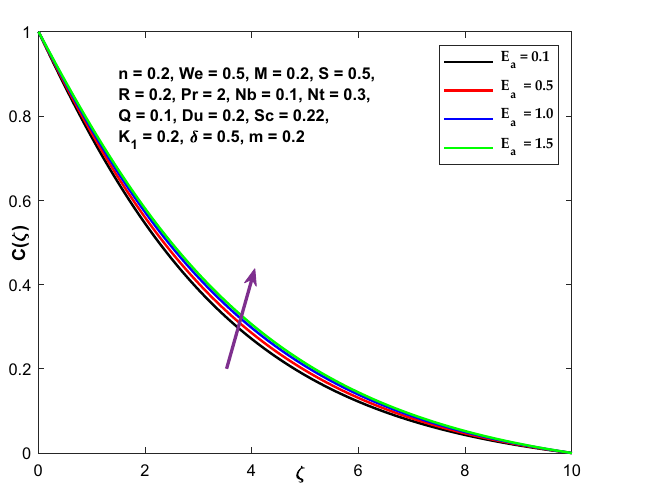
Figure 21. Character of E a versus C (ζ) .